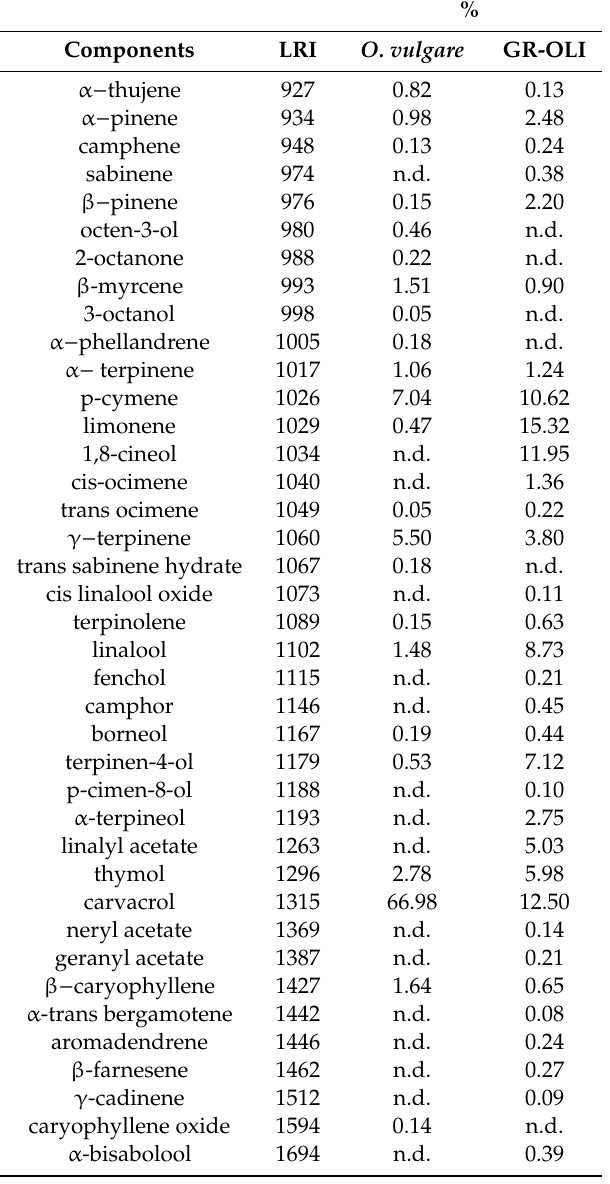
Table 1. Chemical composition and LRIs of natural